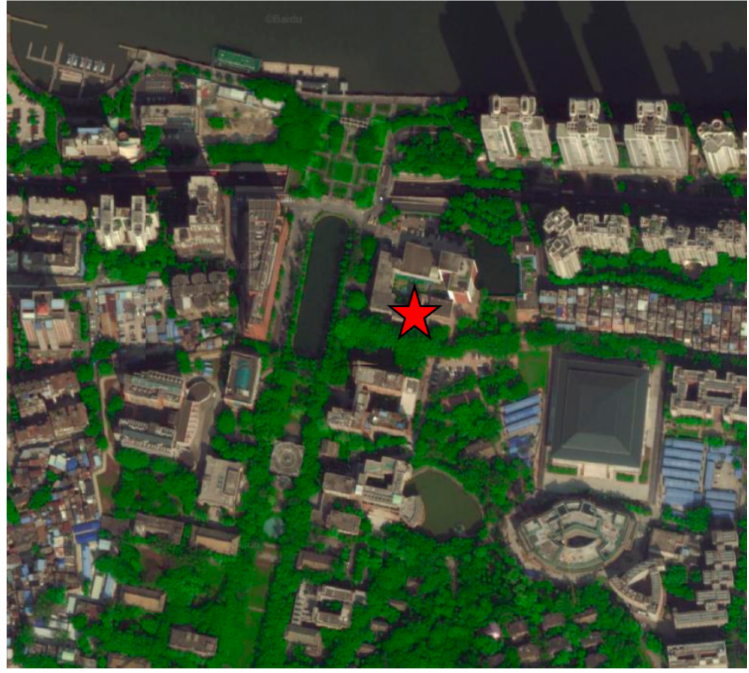
Figure 1. The location of CE318 (from ditu.baidu.com) (accessed on 10 January